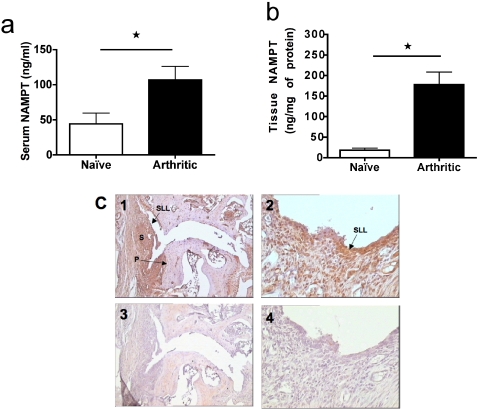
Induction of NAMPT expression in collagen-induced arthritis.Sera (a) and tissue extracts of paws (b) from CIA at day 14 (n = 8) and from non-arthritic, non-immunized, naïve (n = 7) mice were prepared and analyzed by NAMPT ELISA. *P<0.05 arthritic versus naïve in panel a and b. (c) NAMPT immunohistochemistry was performed on paw joints, using a specific rat anti-mouse NAMPT antibody (panels 1 and 2). Staining specificity was confirmed using an irrelevant isotype-matched antibody as primary antibody (panels 3 and 4). Synovial lining layer (SLL), synovial membrane (S) and pannus (P). Original magnifications: x100 for panels 1 and 3; x400 for panels 2 and 4.